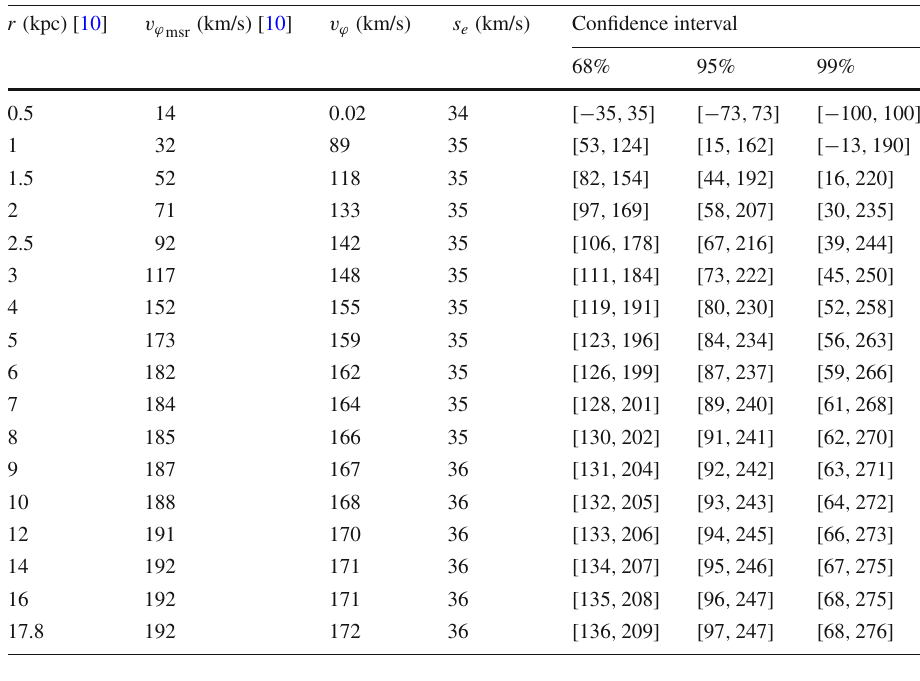
calculated velocities, standard errors and confidence intervals for the NGC 801